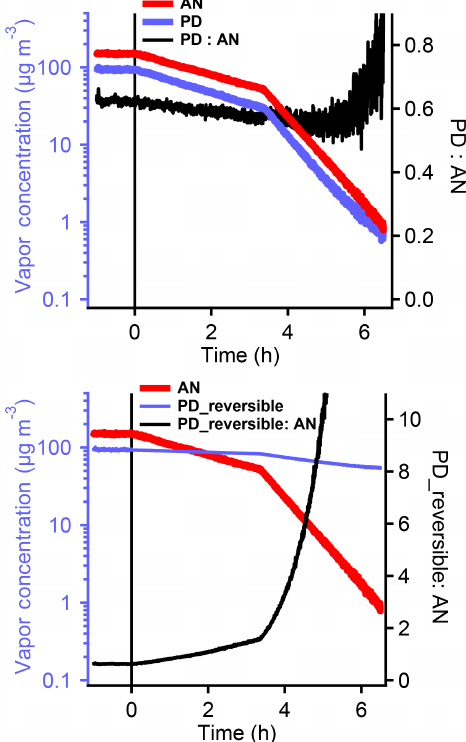
Figure 4. The change in PD and AN concentrations during isother- mal dilution of the chamber with fresh air, which mimics the deple- tion of PD during the SOA formation (top). The ratio of PD to AN shows very small change until the PD concentration dropped below 2µgm − 3 . When considering the deposition of PD on the Teflon chamber walls as reversible partitioning, the predicted PD and AN concentration change during the dilution was shown at the bottom. The decrease in the predicted PD concentration should be slower than the decrease in AN. The ratio of the predicted PD to AN con- centration should keep increasing. These indicate that PD does not return to the gas phase from the Teflon at 22 ◦ C but instead still shows a modest loss to the chamber walls. So no further correction for the release or loss of PD is necessary when studying the SOA